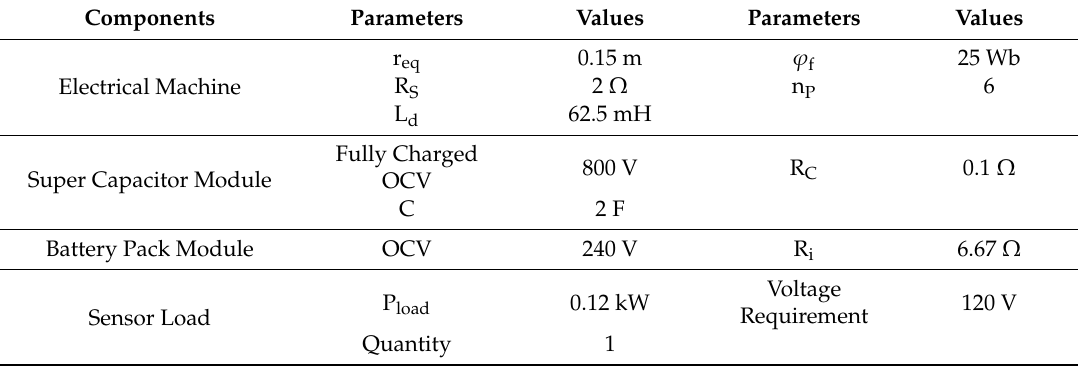
Table 3. Power take-off and energy storage system components design parameters.